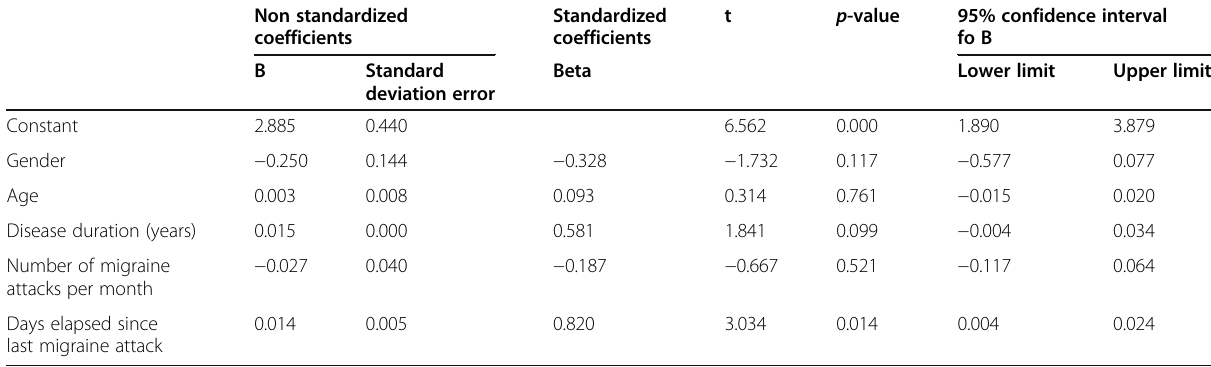
Table 3 Multivariate linear regression model; dependent Variable: rostral anterior cingulate cortex thickness ipsilateral to the migraine pain side recorded during